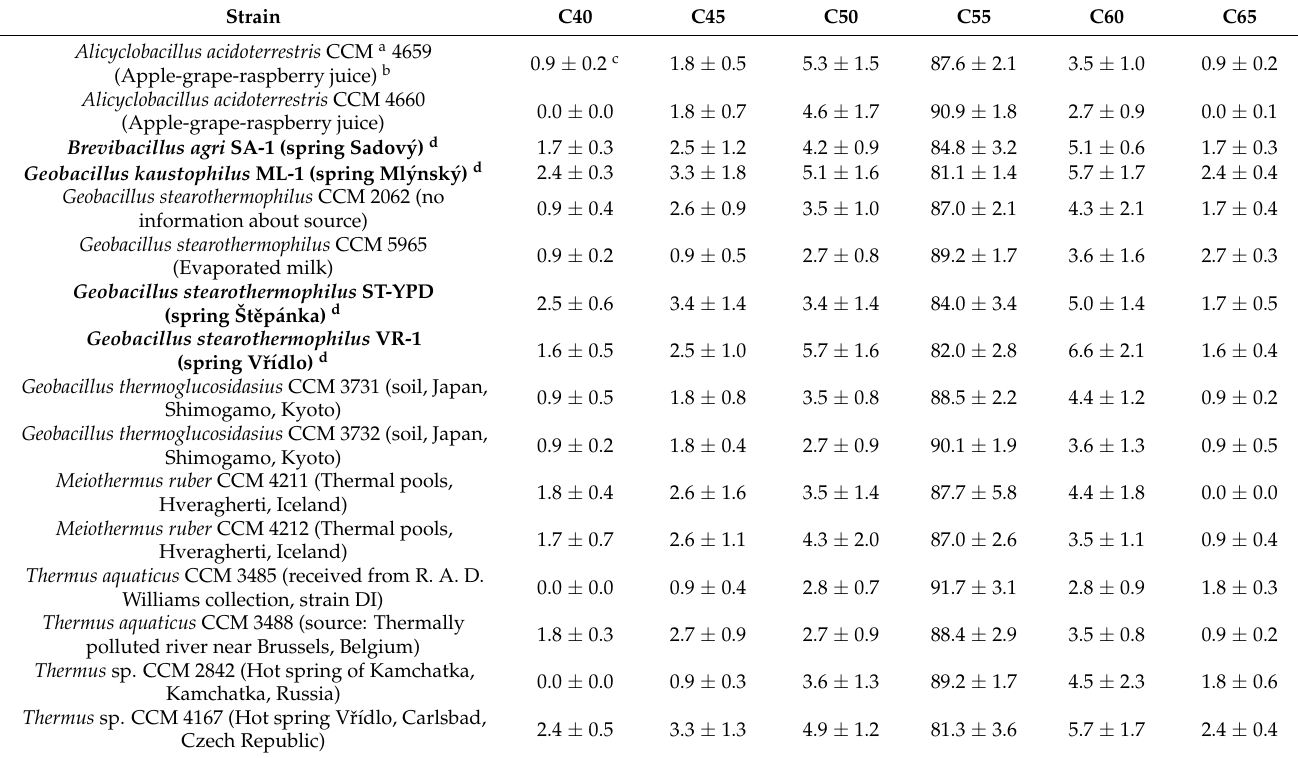
Table 2. Content (relative %) of polyprenol homologs from 16 strains of thermophilic bacteria obtained after saponification using reverse-phase liquid chromatography-positive electrospray mass spectrometry.